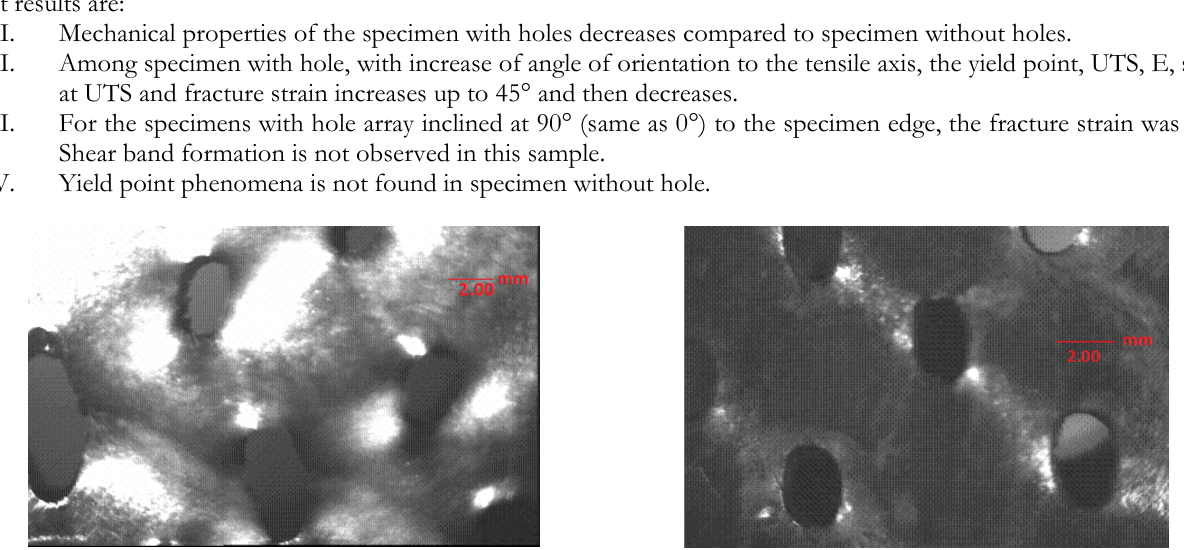
Figure 11: Shear band formation during the tensile deformation of specimen (For Hole orientation (i) 60° and strain at 16%, (ii) 45° and strain at 18 %